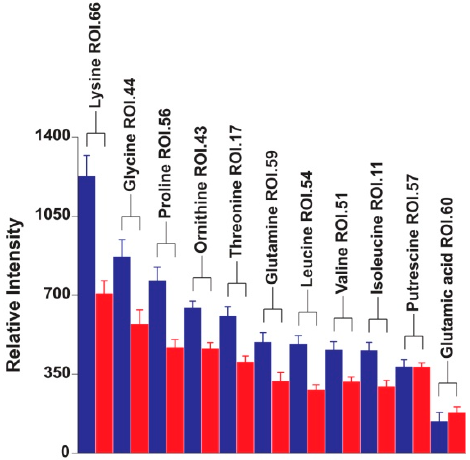
Figure 6. Quantitation of amino acids and amino acid-related metabolites in D 2 O extracts of Helicoverpa armigera larvae. Quantitation was performed on a single 1 H- 13 C HSQC ROI per metabolite. ROIs with the highest variability according to PCA loadings were selected. Herbivores = blue; cannibal = red.